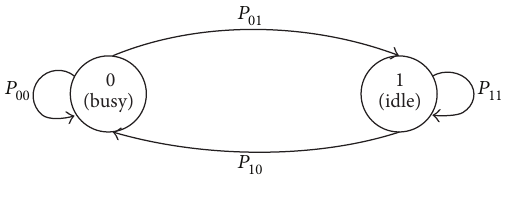
Figure 1: Channel state transition model.